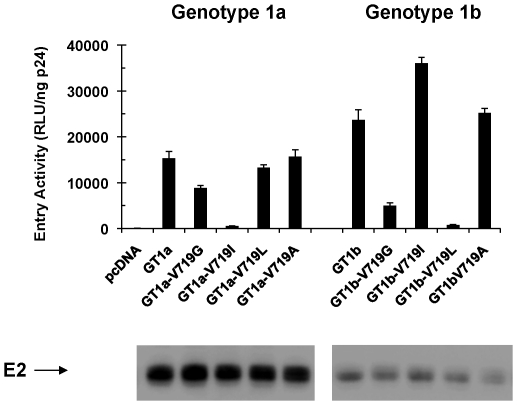
Fusogenic properties of variant envelopes and sensitivity to representative triazines in the HCVpp assay.Individual variants, representing both drug-selected and natural polymorphisms, were introduced by site directed mutagenesis of plasmid vectors that express either the genotype 1a or 1b E1/E2 glycoproteins. Unique HCVpp, representing each variant were produced in 293T cells and normalized by p24 ELISA assay. Viral entry was measured by quantifying luciferase activity as described in the Materials and Methods. Luciferase activity was expressed as R.L.U. per nanogram of p24. Cell lysates were prepared from 293T cells that were previously co-transfected with envelope expression constructs and the HIV-1 vector. After normalizing for total protein content, proteins were then separated by electrophoresis through an SDS-polyacrylamide gel and subjected to western blot analysis with PA-25, a mouse monoclonal antibody raised against sE2 derived from a genotype 1a strain.